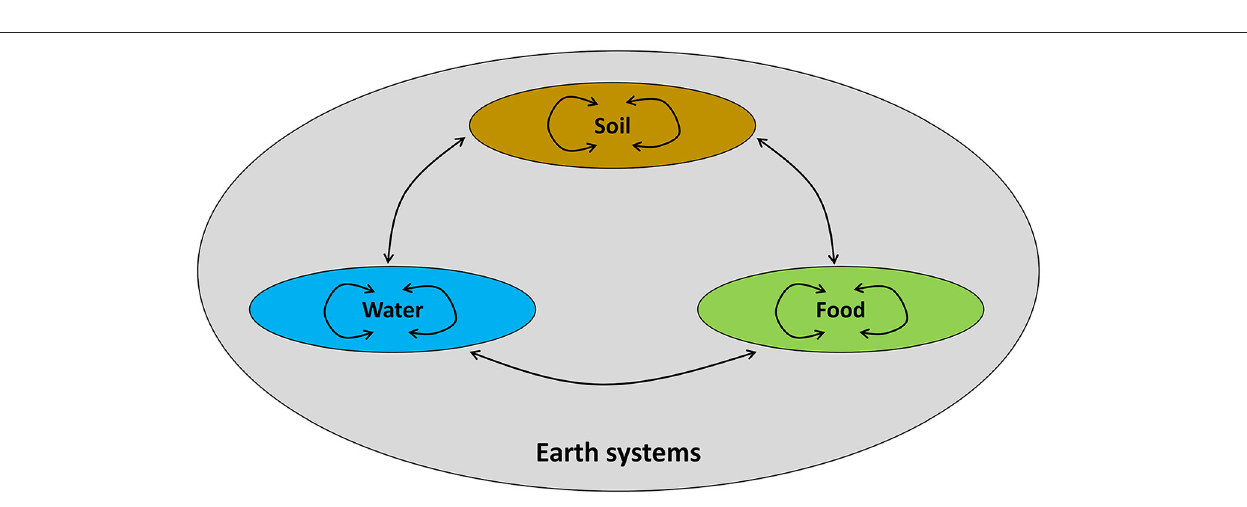
FIGURE 6 | The nature of cascading systems as applied to soil-food-water systems examined in this